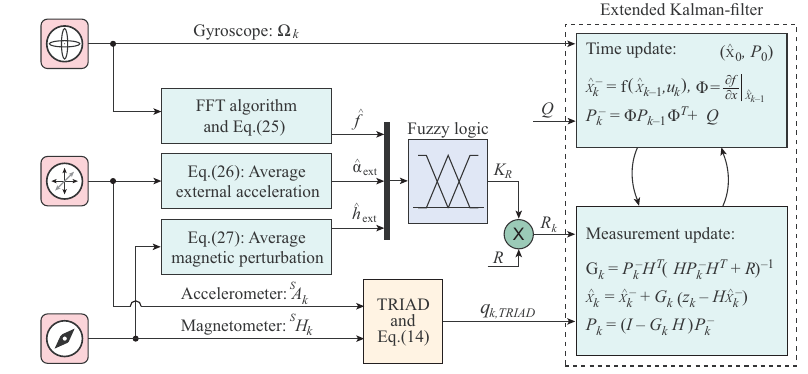
Figure 2. Structure of the FAEKF.